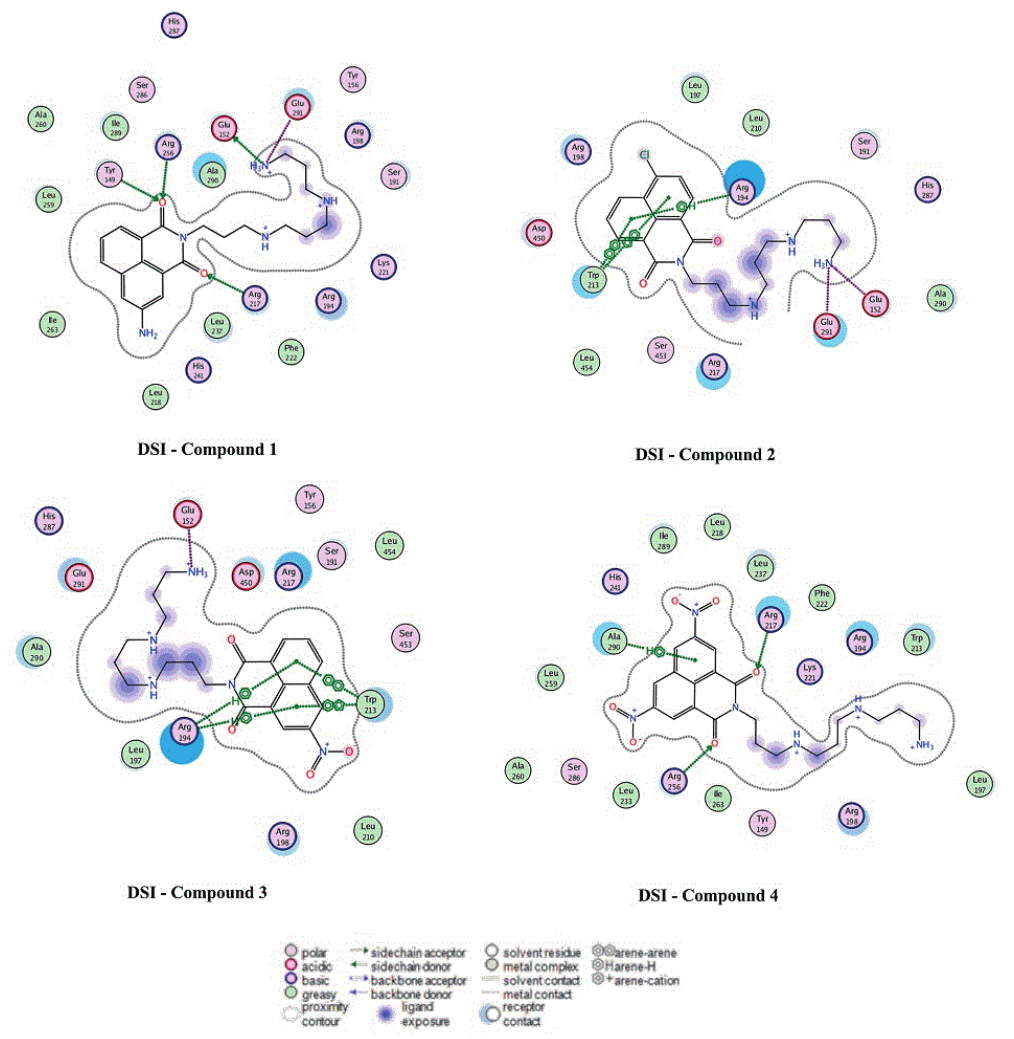
Figure 13. Docking experiment results showing the 2D diagrams of the binding modes of the complex DSI-compounds 1 – 4 . Polar and non-polar residues were represented in red and green circles, respectively. H-bond acceptors or donors were shown in green-dotted arrows. Electrostatic interactions from ion pairs were presented in red-dotted lines. π - π and π -H interactions were represented in green-dotted